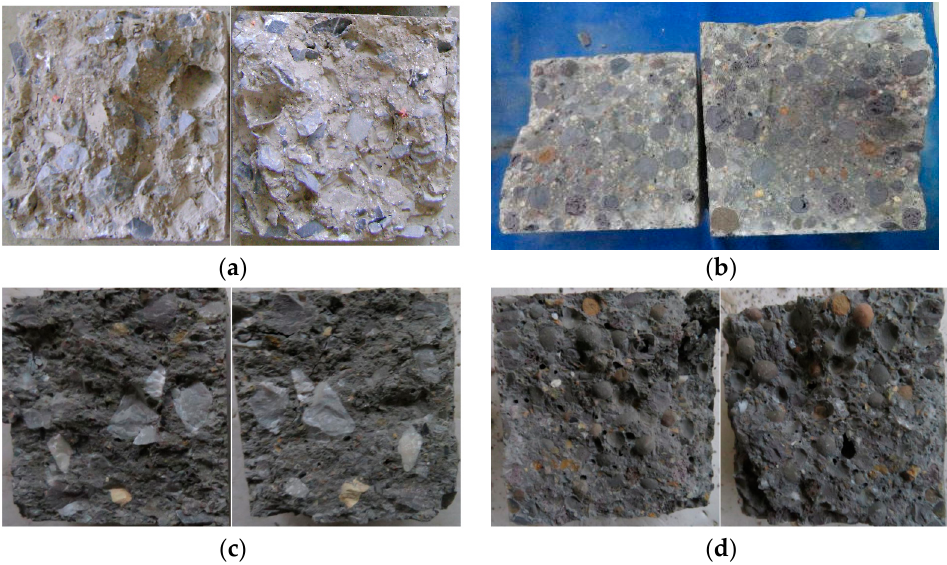
Figure 7. Typical splitting surfaces of cube specimens: ( a ) NOPC; ( b ) LOPC; ( c ) NAAC; ( d ) LAAC.